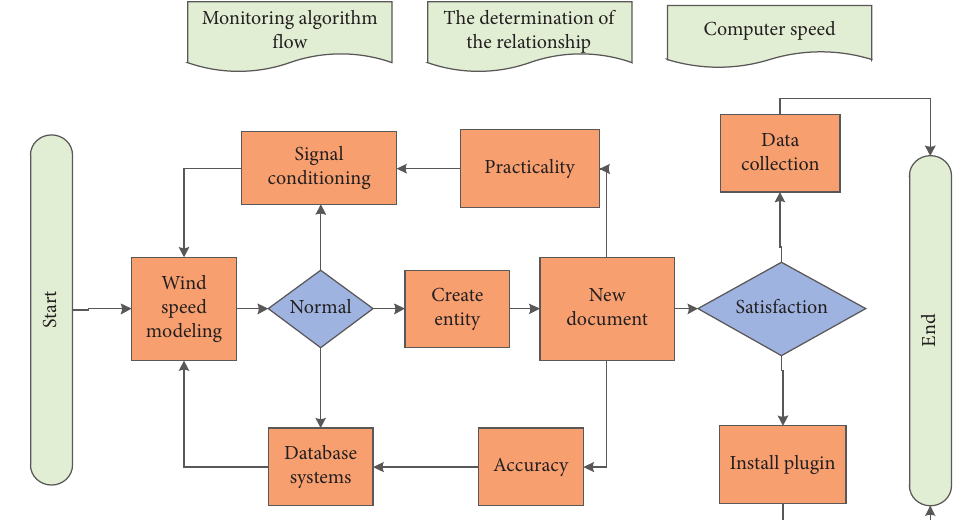
Figure 2: Computer speed monitoring algorithm